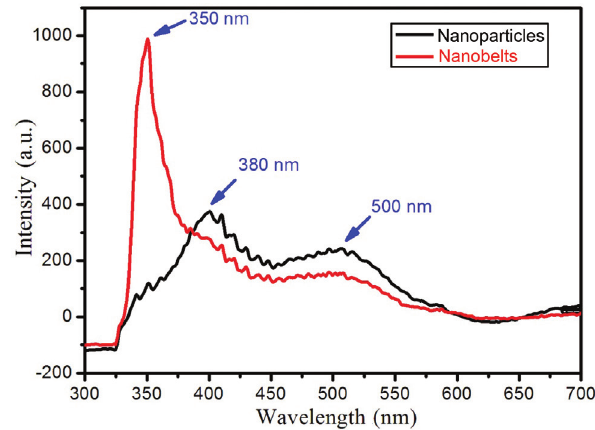
Figure 7 Photoluminescence (PL) spectra of two kinds of